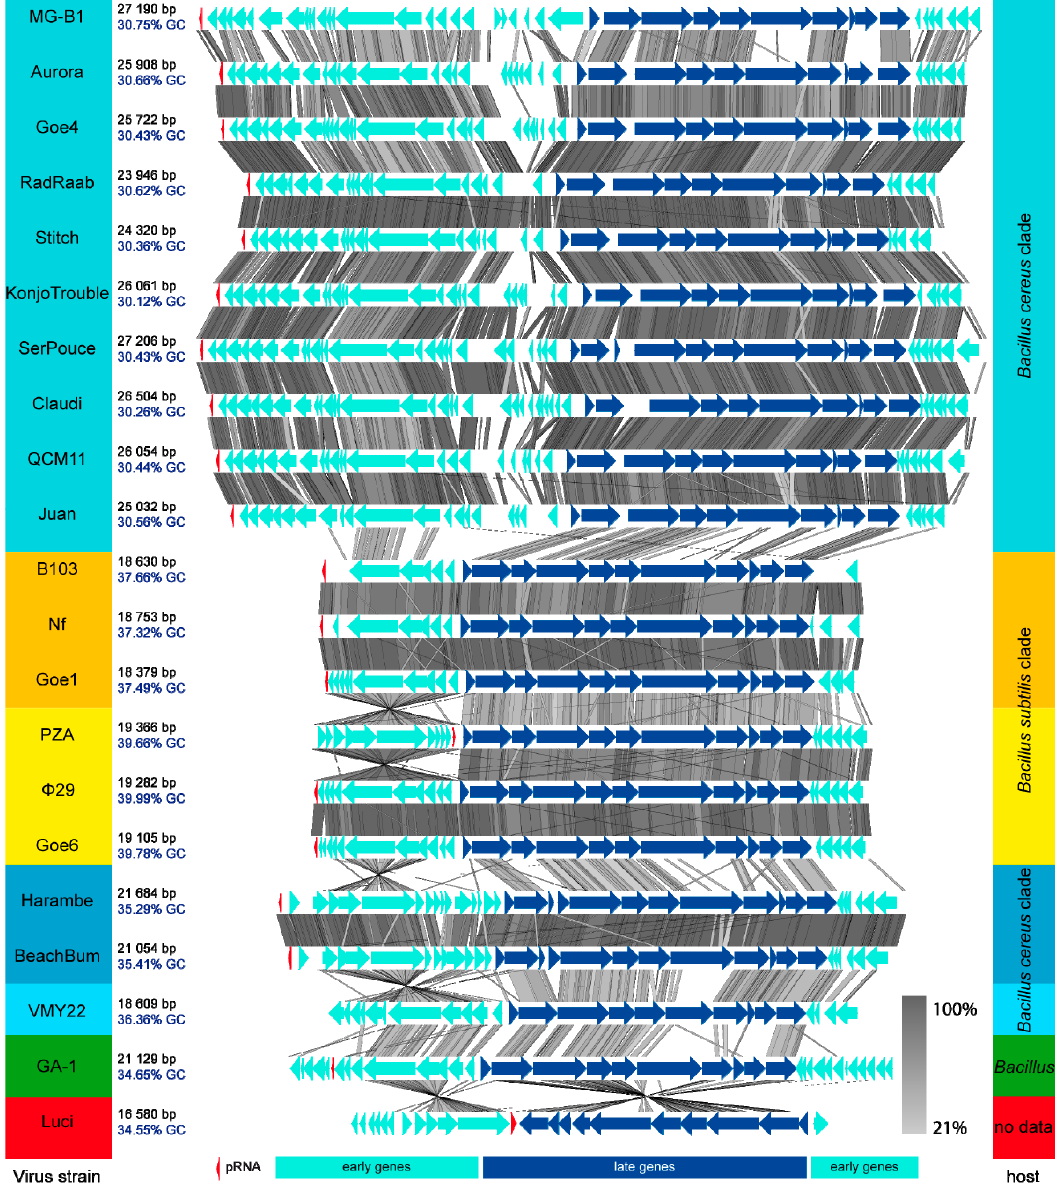
Figure 4. Blast Comparison of all φ 29-like Phages. Genomes are ordered like presented in the ANI analysis in Figure 3. Phages are compared via tblastx using the Easyfig tool [30]. Name, genome size and GC-content of each phage are listed on the left side and highlighted in colour. Members of the same cluster are equally highlighted. The respective hosts are listed on the right side. Bluish highlighted strains infect hosts of the B. cereus clade, yellowish highlighted strains infect hosts of the B. subtilis clade. pRNA genes are shown as red arrows and were identified via a covariance model created during this investigation (supplemental pRNA-Nf-GA1.cm).